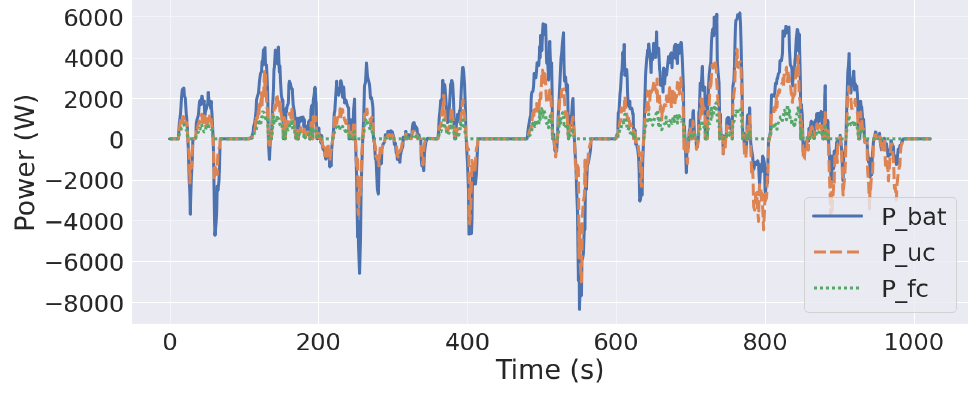
Figure 12. Battery, UC and FC powers by DRL.